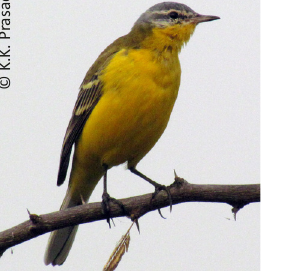
Image 55. Grey Wagtail Mot- acilla cinerea